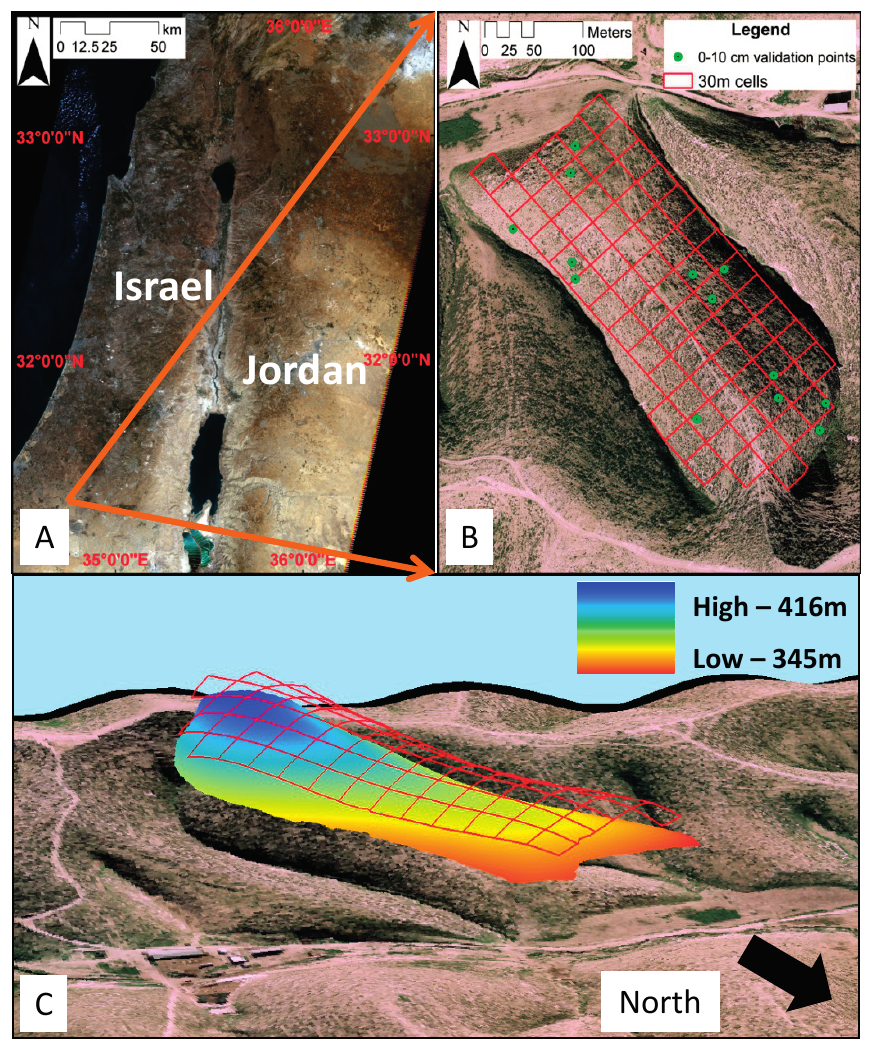
Figure 1. The study site: ( A ) the Lehavim long-term ecological research area in central Israel; ( B ) the hillslope under study; the 30-m cells are marked in red, and the locations of the validation points on the ground are marked in green. ( C ) A 3D representation of the hilly terrain of the study